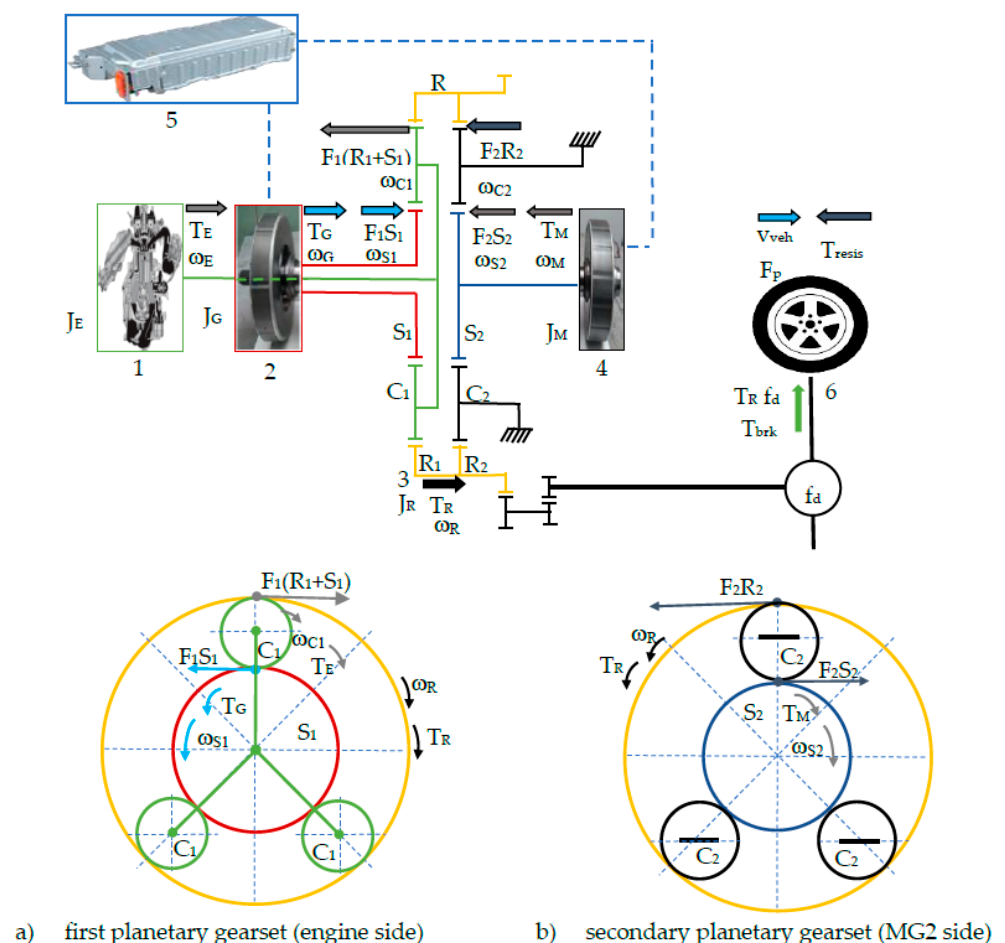
Figure 2. Torque transmission dynamics model (normal driving mode): 1—combustion engine, 2—MG1 electric machine (starter, generator), 3—planetary gear assembly, 4—MG2 electric machine (electric motor, generator), 5—traction battery, 6—wheels.